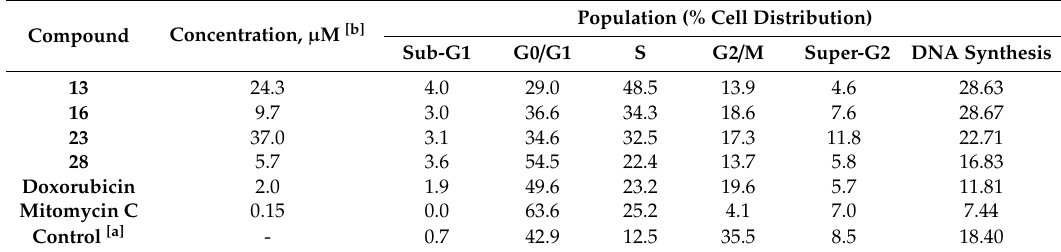
Table 3. Cell cycle analysis in malignant glioblastoma cell line SNB-19.